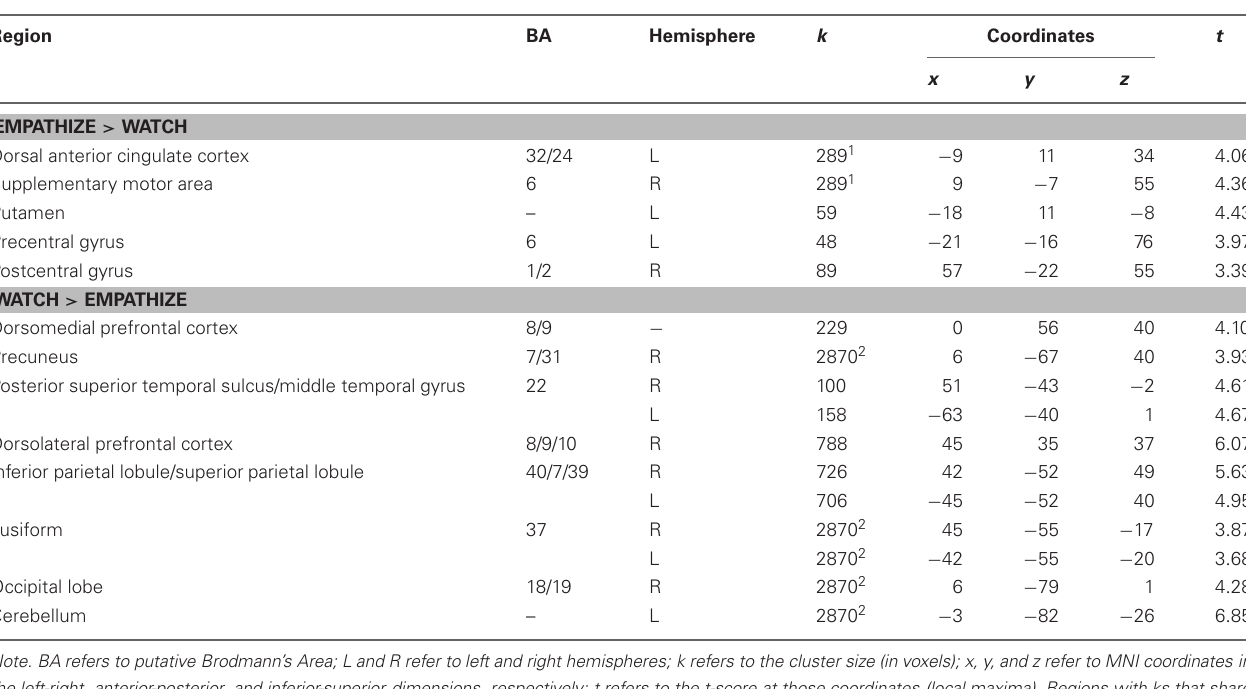
people under cognitive load while looking at emotional